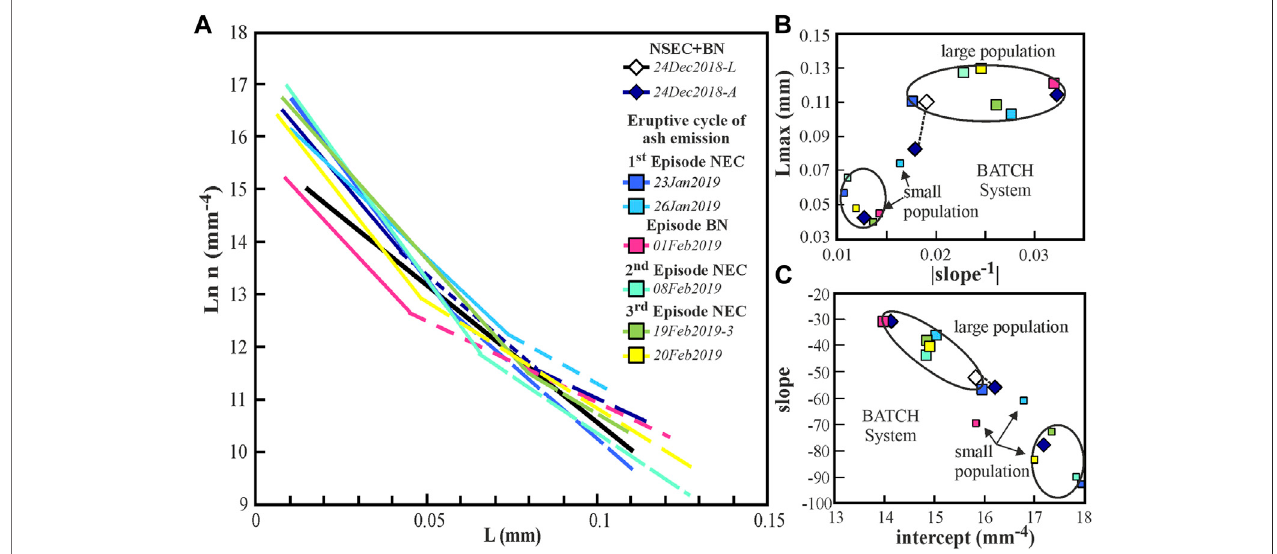
FIGURE 10 | Results from quantitative textural analyses. (A) Crystal size distribution (CSD) plot for plagioclase microlites in the studied samples. (B,C) Diagnostic relationships between the maximum crystal size (Lmax) and an inverse slope (absolute value) (B) and between the intercept and the slope for each identi fi ed population from CSD (C)